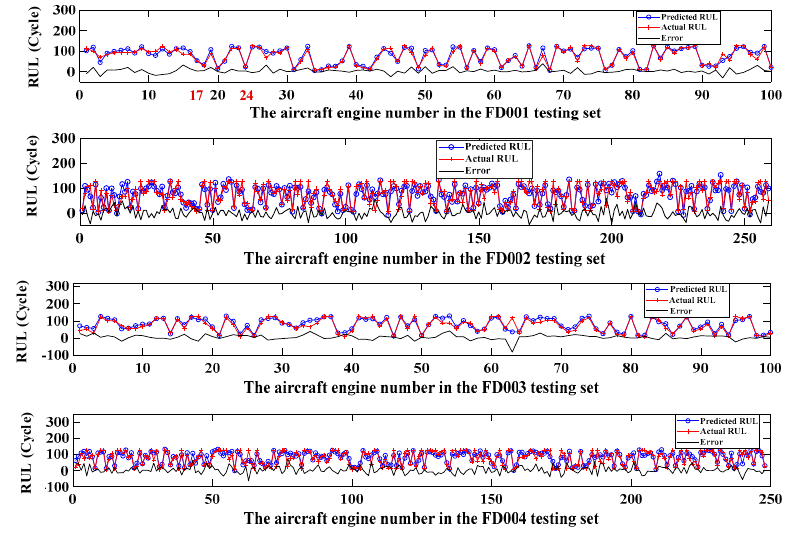
Figure 7. Prediction results on the testing dataset.